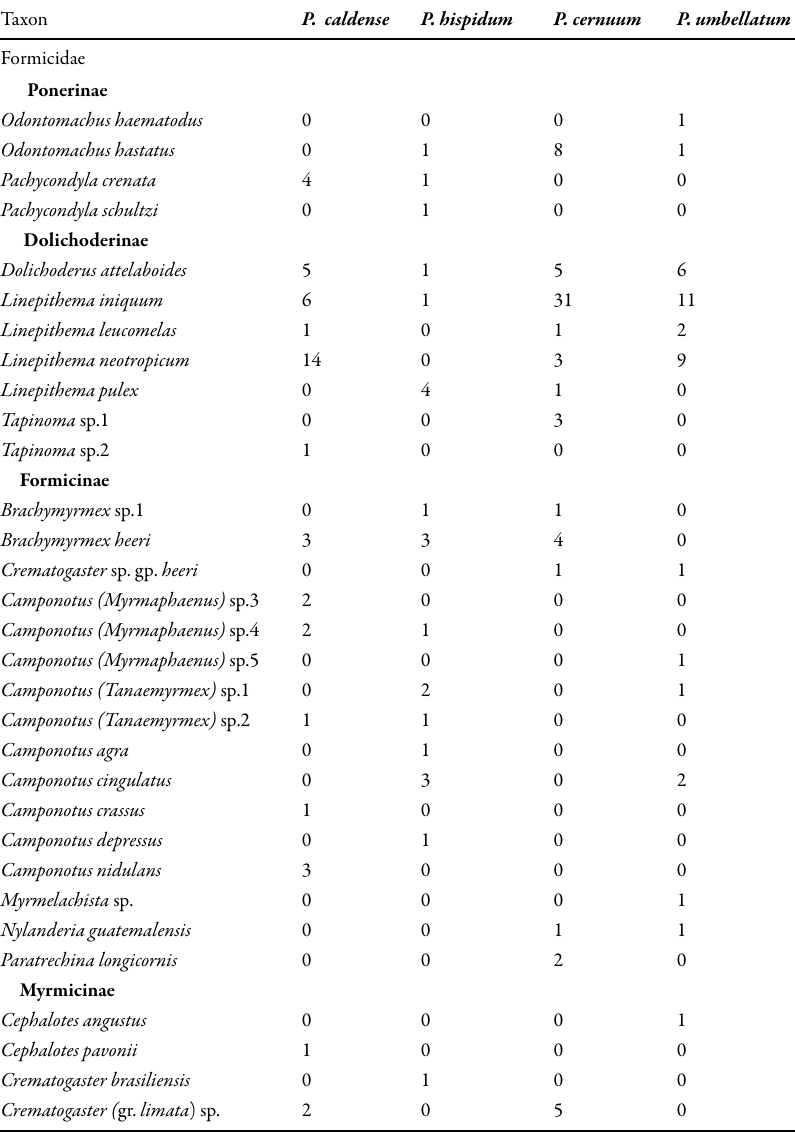
Table 1. Ant species collected, and related ecological characteristics, on four species of Piper , September 2010 to May 2011, Serra Bonita RPPN, Bahia, Brazil. *probable artifacts due to the large proportion of singletons in the sampled